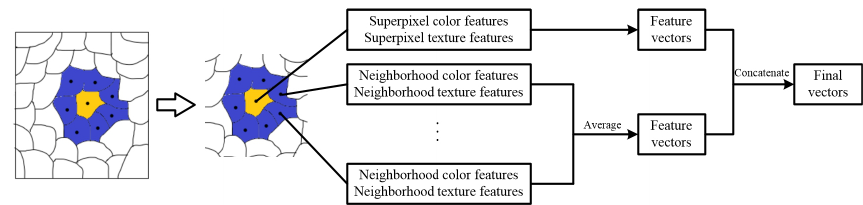
Figure 1. Superpixel-based feature extraction